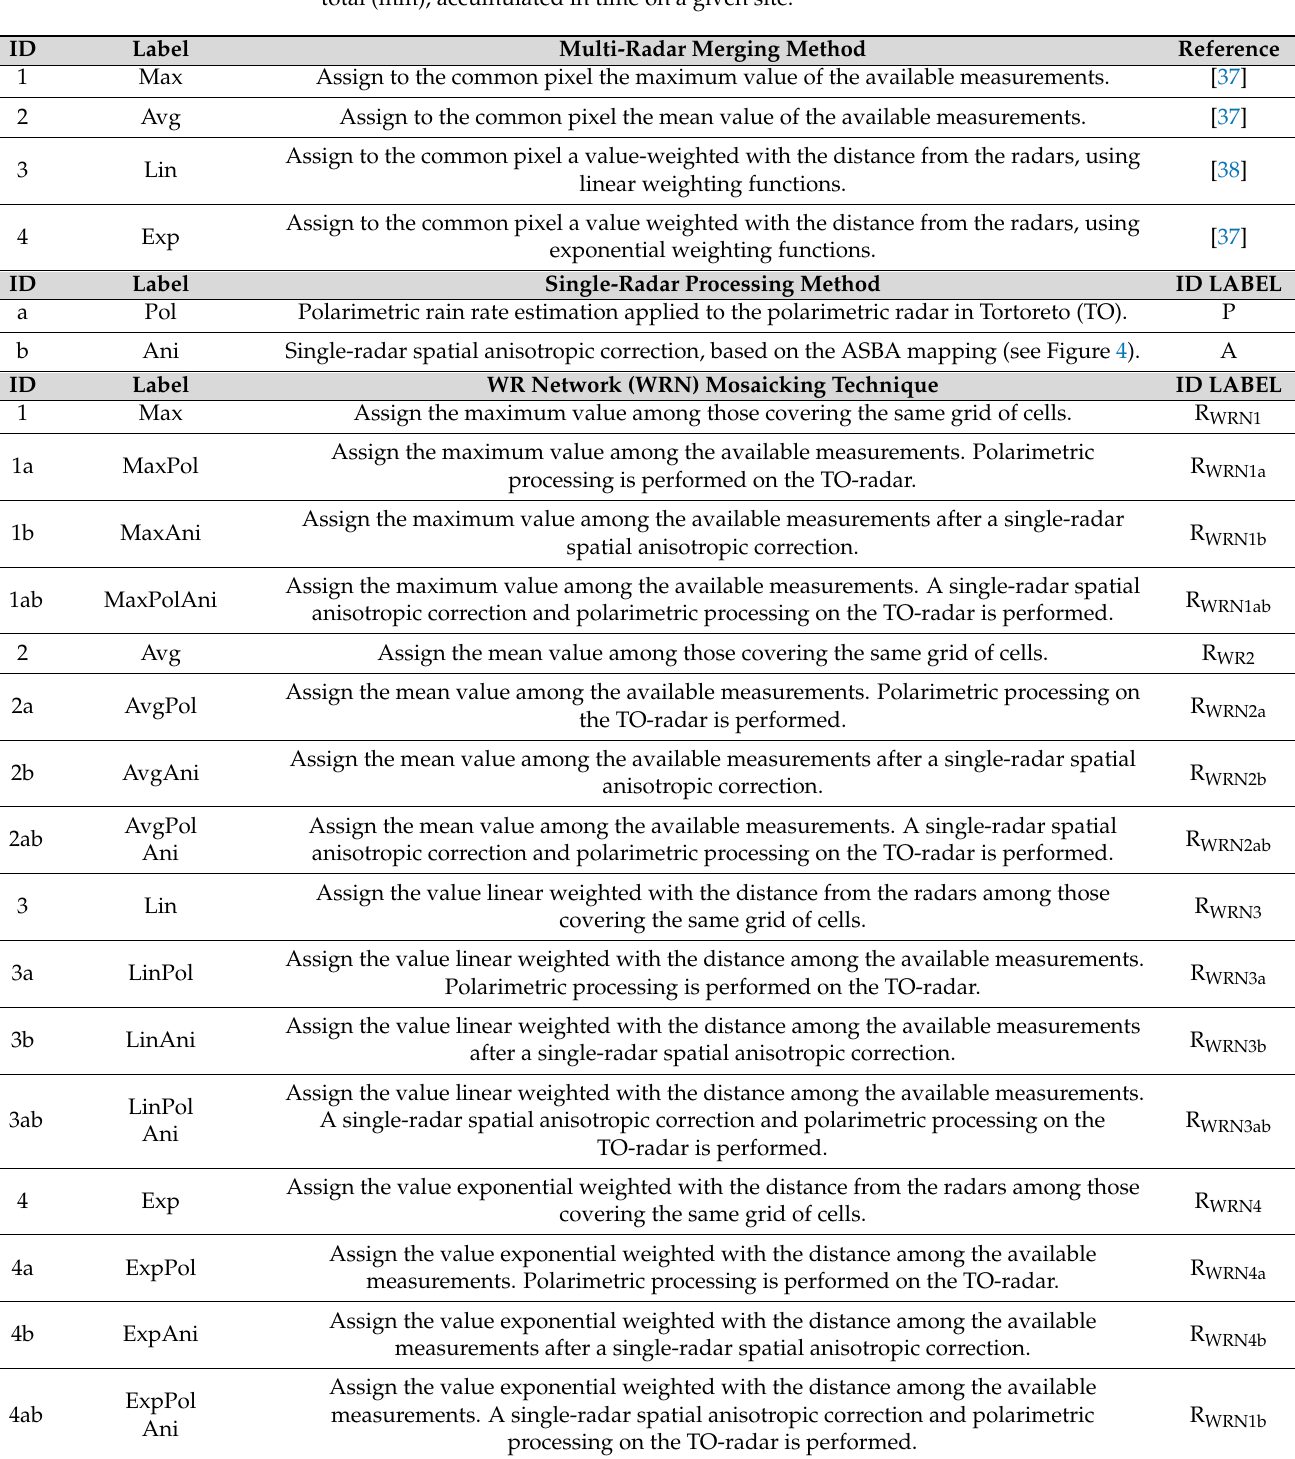
Table 3. Merging strategies for multi-radar mosaicking, tested in the Abruzzo composite domain (see Figures 1 and 5). The identification (ID) number lists the merging (from 1 to 4) and processing (a or b) methods and then their combination as a merging technique (from 1a to 4ab). SRT is the surface rain total (mm), accumulated in time on a given site. Multi-Radar Merging Method